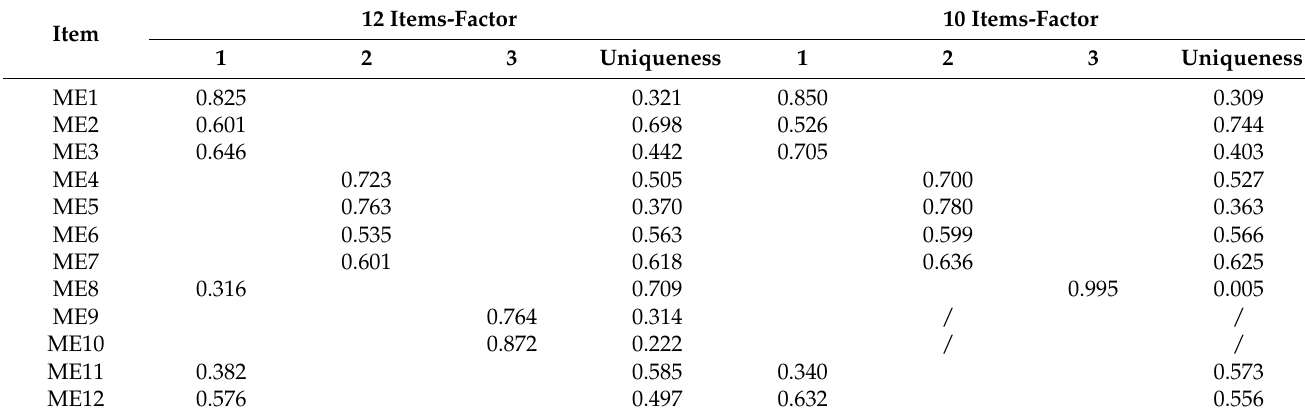
Table 2. The factor loading resulted from parallel analysis.